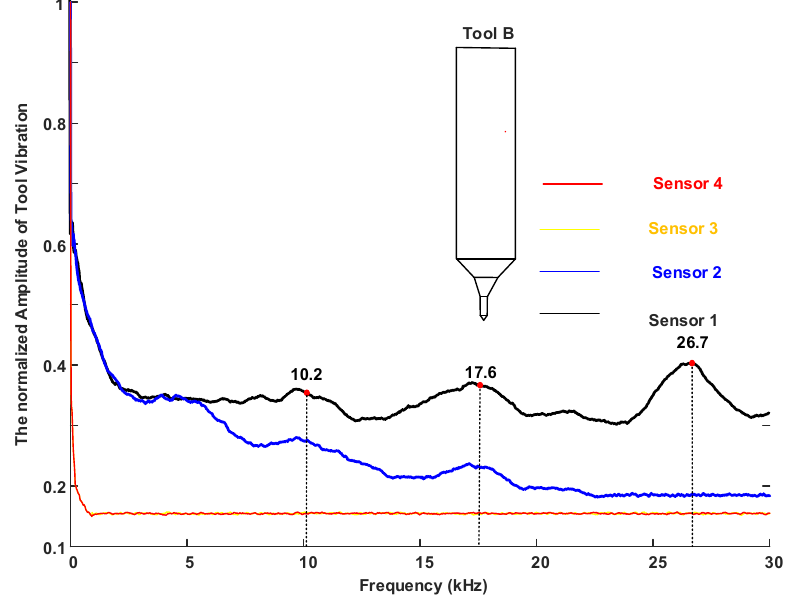
Figure 15. Frequency propagation of Tool B based on impact response.